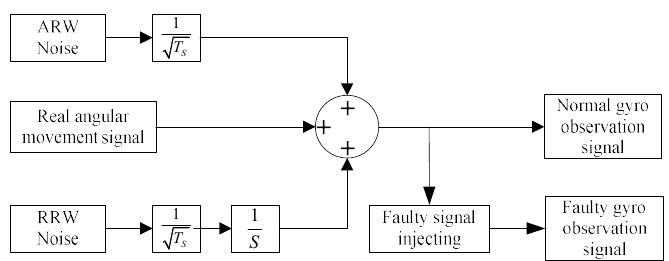
Micromachines 2019 , 10 , x